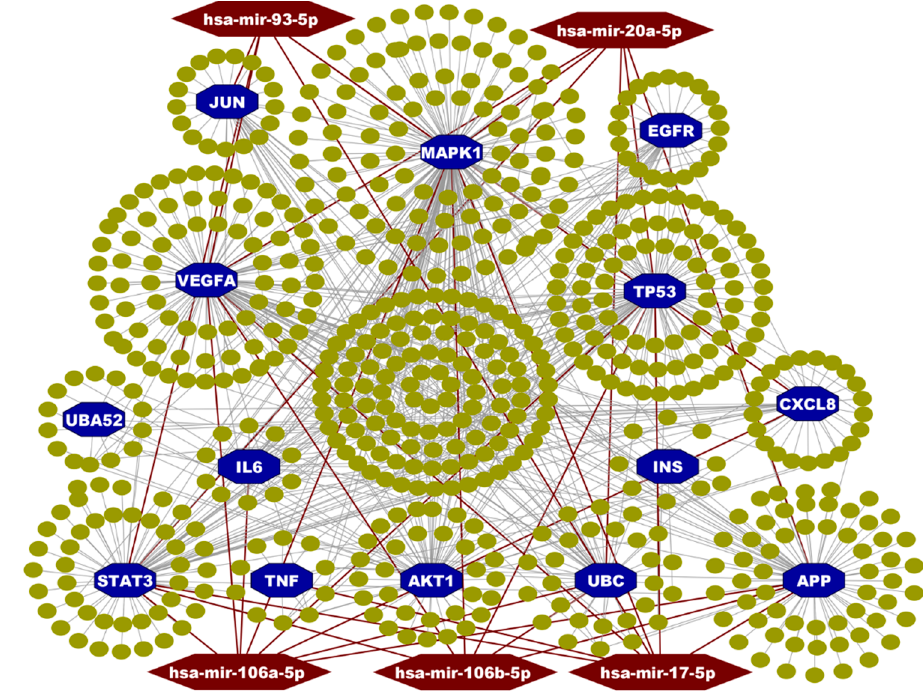
Figure 5. The miRNAs versus hHub-DEGs interaction network that were detected the key regulatory miRNAs of hHub-DEGs. Here, hHub-DEGs were marked as a blue color with octagon shape in both A and B. The key miRNAs were marked as a red color with a hexagonal shape and small ellipses represents other miRNAs.